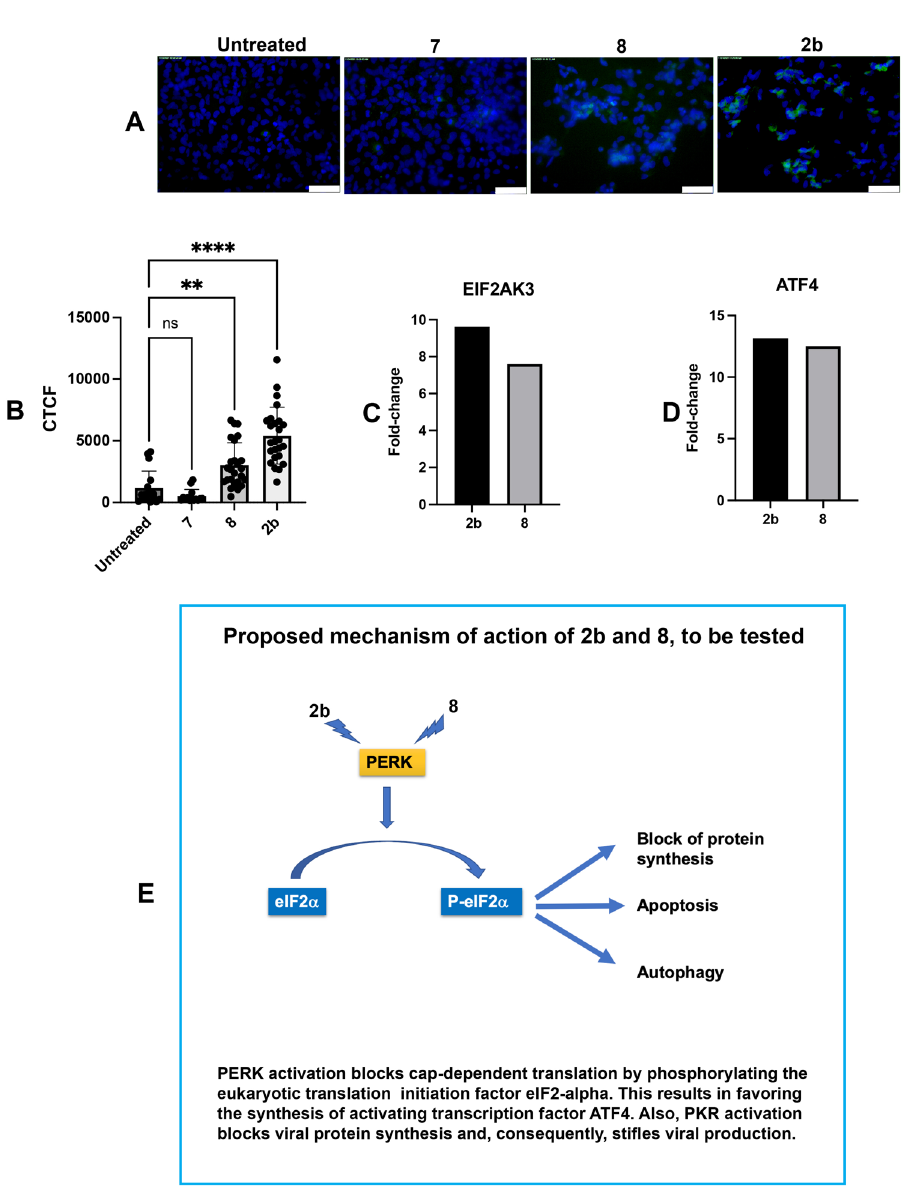
Figure 8. Activation of the integrated stress response in 2b- and 8-treated NPCs. ( A ) NPCs derived from 9001 iPSC lines were exposed to compounds 7 , 8 , and 2b (10 μM). After 24 h, cells were fixed and stained with an antibody that detects eIF2α phosphorylated on Serine 51 (EIF2S1). Nuclei were counterstained with Hoechst 33342, and phosphorylation was assessed by fluorescence microscopy. ( B ) The corrected total cell fluorescence (CTCF) was obtained by measuring EIF2S1 fluorescence in cells where a fluorescent signal could be detected and normalizing for cellular area using equation CTCF = integrated density − (cellular area × mean fluorescence of background readings). Error bars are standard deviations. One-way analysis of variance (ANOVA) followed by Bonferroni post-hoc test was used to compare CTCF among the different conditions: ** ( P = 0.0042); **** ( P < 0.0001). ( C , D ) Up-regulation of the EIF2A kinase EIF2AK3 ( C ) and the activated transcription factor 4 (ATF4) ( D ) in 2b - and 8 -treated NPCs. Fold-changes were calculated from RNA-seq data described in the methods section. ( E ) Proposed mechanism of action of 2b and 8